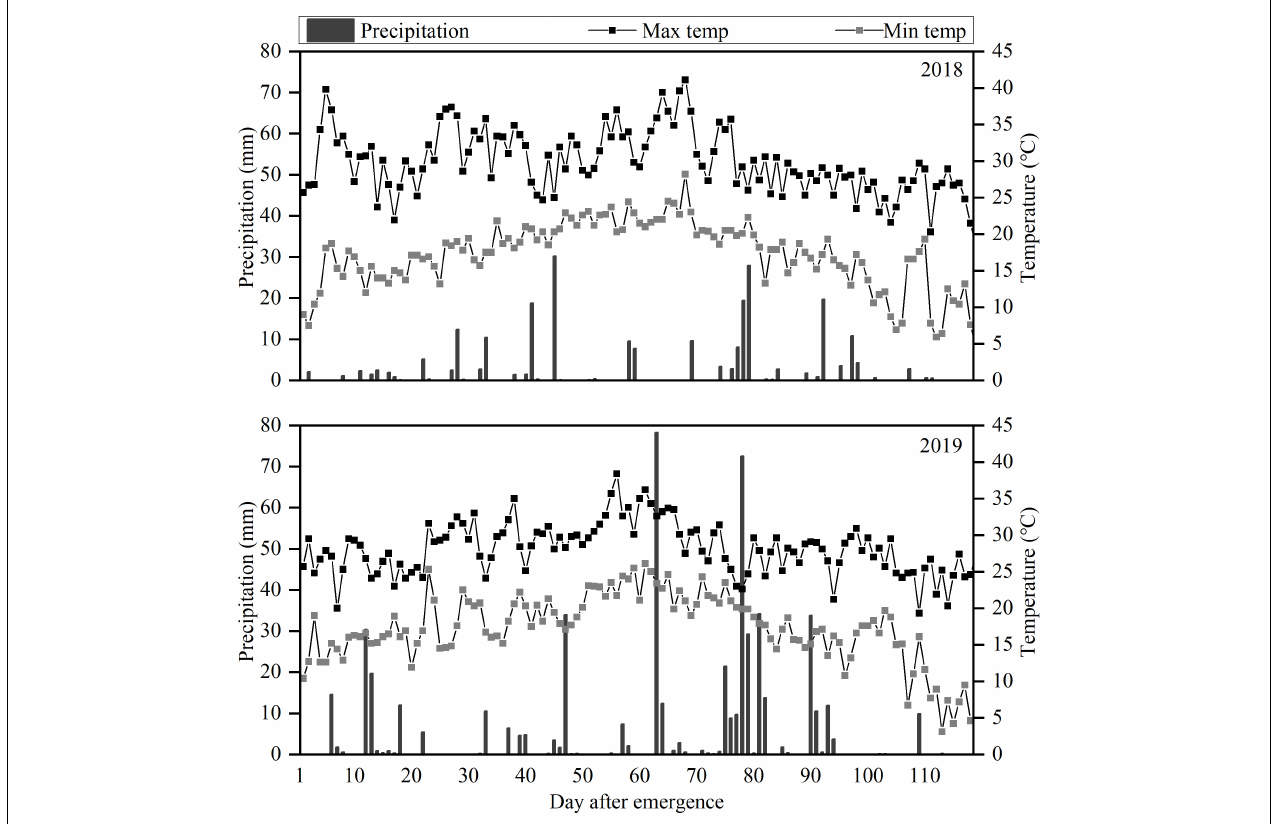
FIGURE 1 | Daily precipitation and maximum (Max) and minimum (Min) temperatures during the 2018 and 2019 peanut growing seasons.